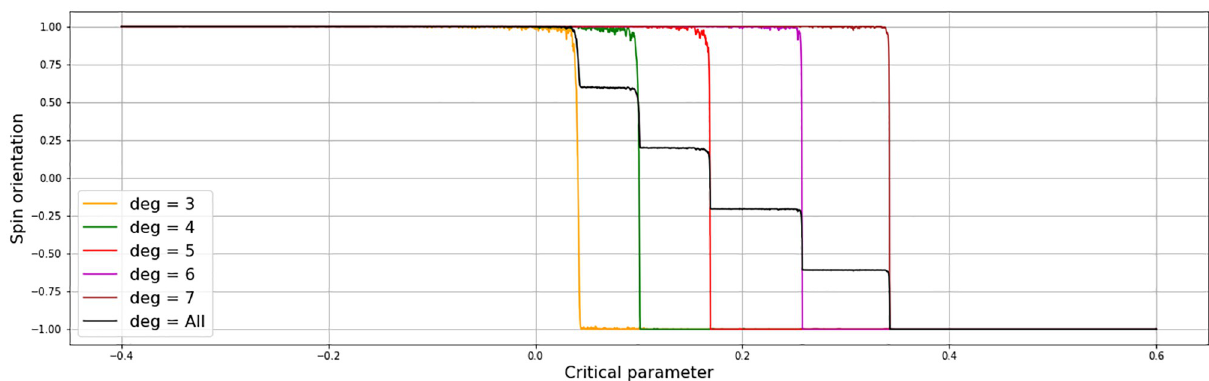
Fig 3. Critical transition in networked Ising implementation with 2000 nodes in groups of 400 with a link degree deg 2 {3, 4, 5, 6, 7} (correspondent to: Orange, green, red, magenta, brown) and iteratively driven into an assortativity of 0.997, with h linearly increasing over 3000 timesteps from -0.4 to 0.6 (note that the usual implementation of the Ising is done in a von Neumann neighborhood, for which a much smaller range of h suffices to trigger the spin